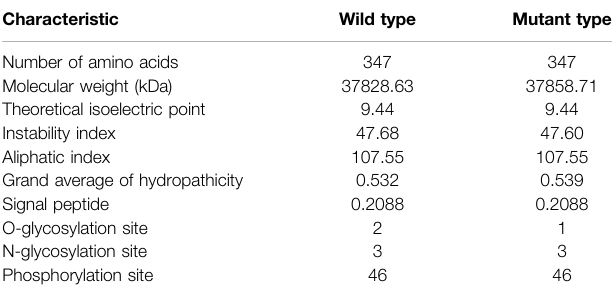
TABLE 3 | Physicochemical properties of protein between wild type and mutant type in SNP7.